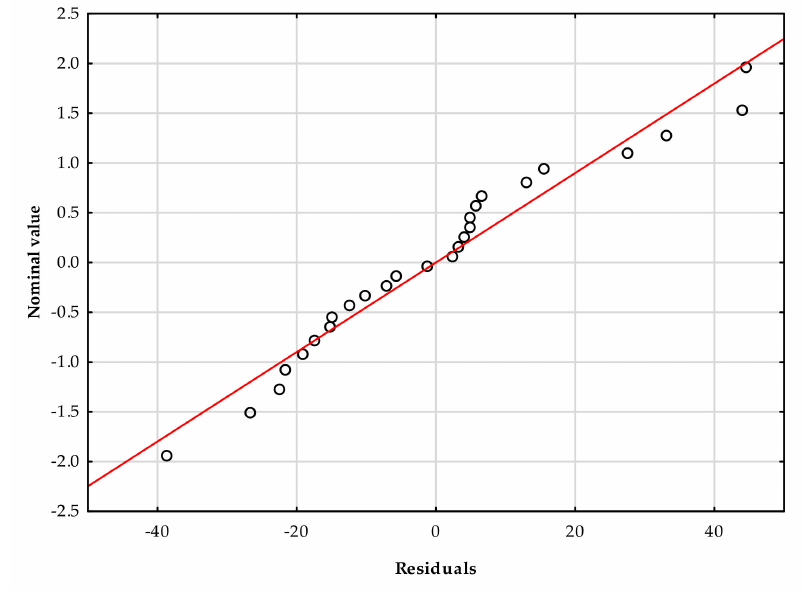
Figure 13. Diagram of normal distribution of residues for the model for estimating Q MED in mountain catchments of the Upper Vistula basin; points represent residuals of model versus normalized values of